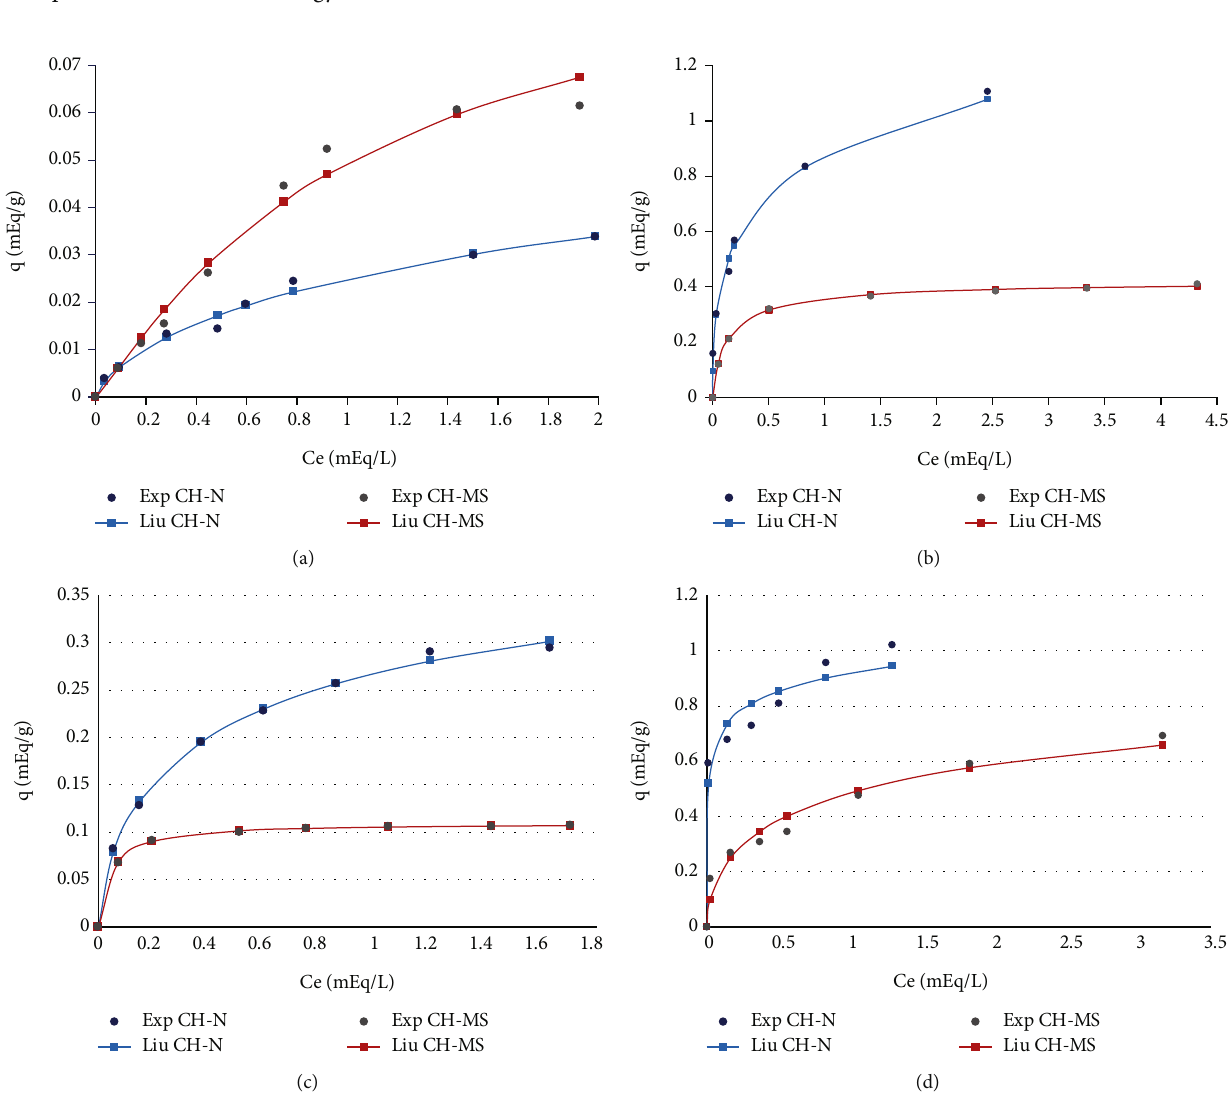
Figure 8: Isotherms for the adsorption of (a) As(V), (b) Pb(II), (c) Cd(II), and (d) Cr(III) on CH-N and CH-MS zeolites at pH 4 and their correlation with Liu